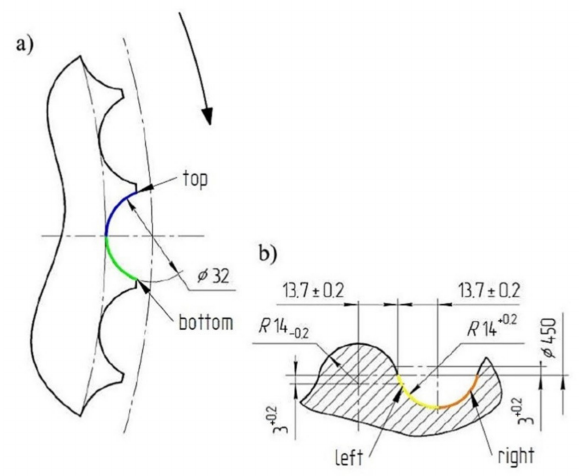
Figure 3. Geometry of tools cavities on the working surface of rolls used for briquetting: ( a ) front view, ( b ) cross section through the groove.